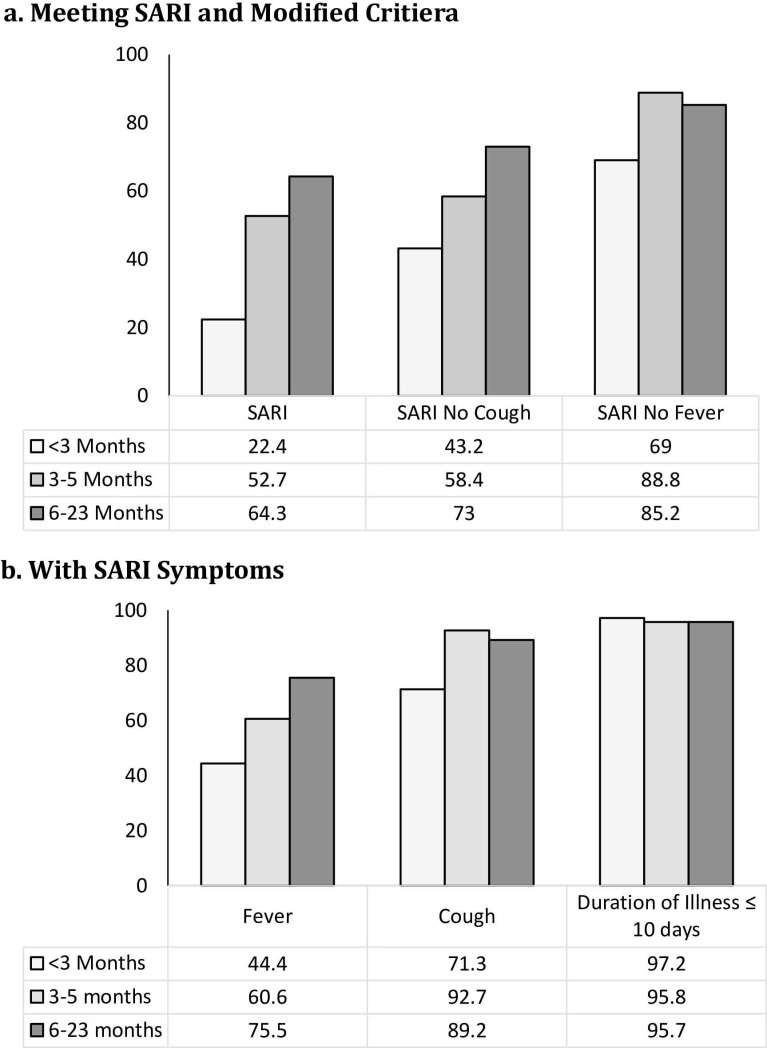
Virus positive patients stratified by age.